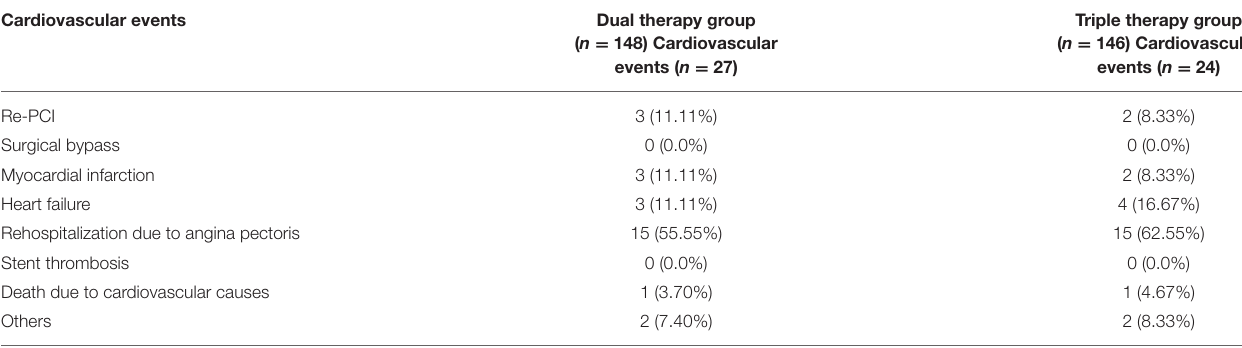
TABLE 4 | Specific description of cardiovascular events in 2 groups of patients.